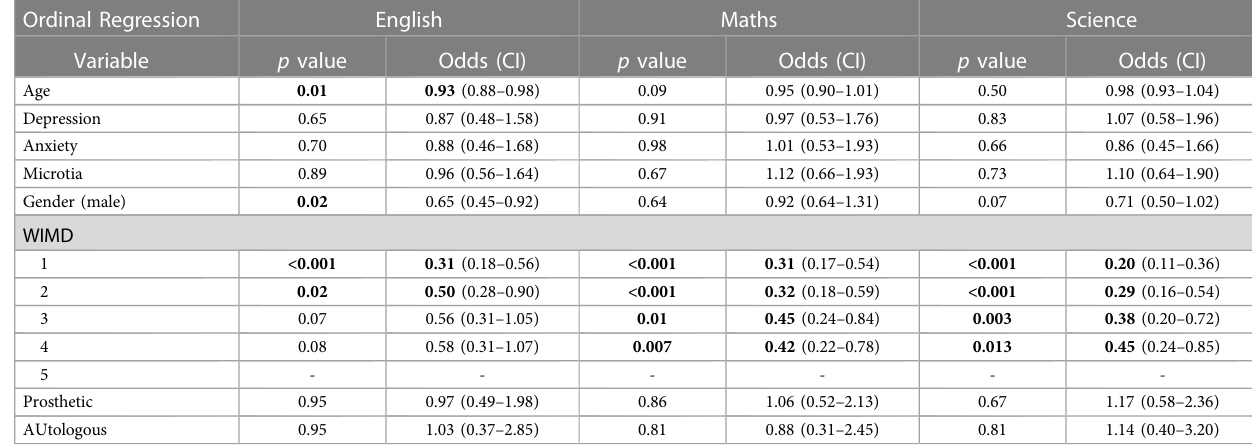
TABLE 3 Summary table of regression analyses to determine odds ratios of age, depression anxiety, microtia, gender, deprivation and surgical intervention on KS2 assessment performance. Ordinal Regression